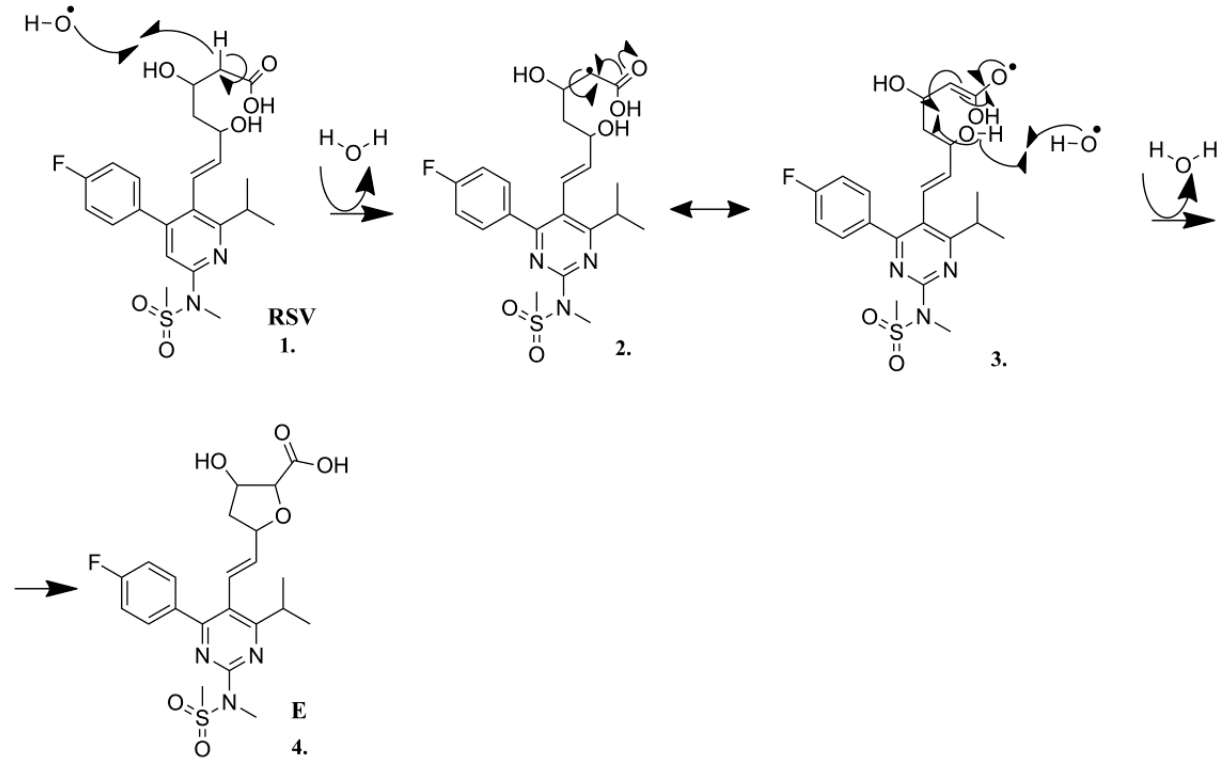
Figure 8. Fragmentation MS/MS spectra of product E [M + H] + ion (precursor ion mass m/z 480.1600) obtained by using collision energy of 25 V.